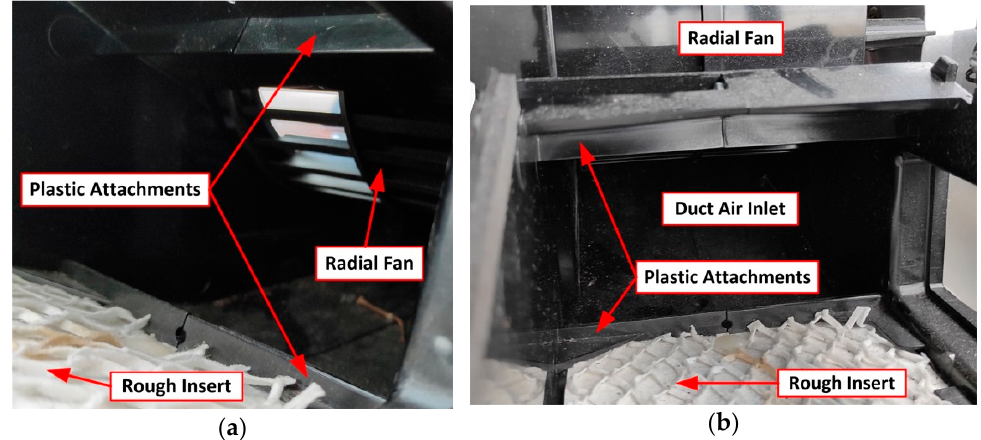
Figure 10. Interior of the cooling duct close to the fan outlet. ( a ) side view and ( b ) front